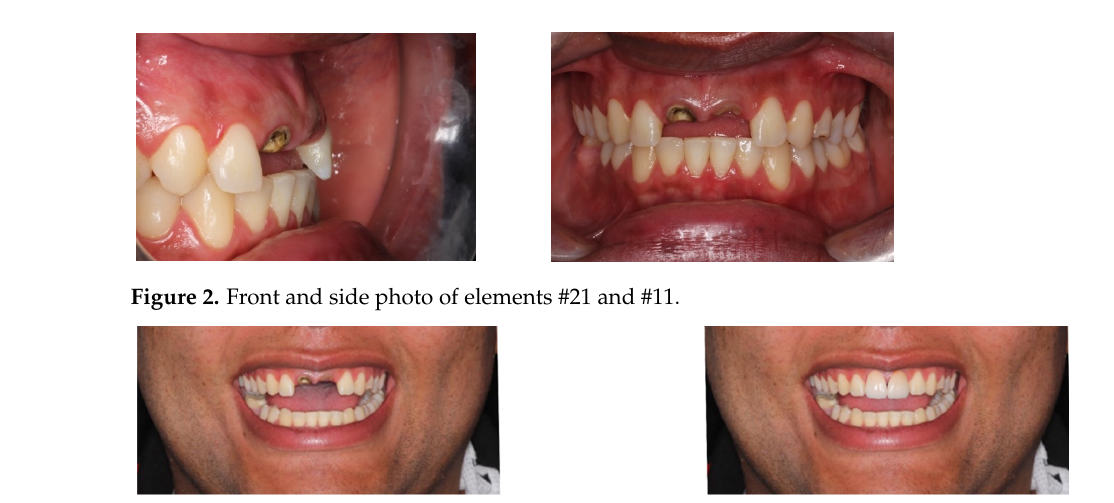
Figure 1. Initial tomography.